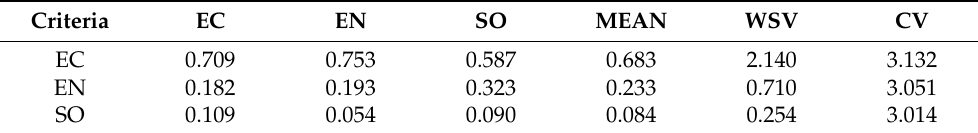
Table 10. Normalized matrix for CR.